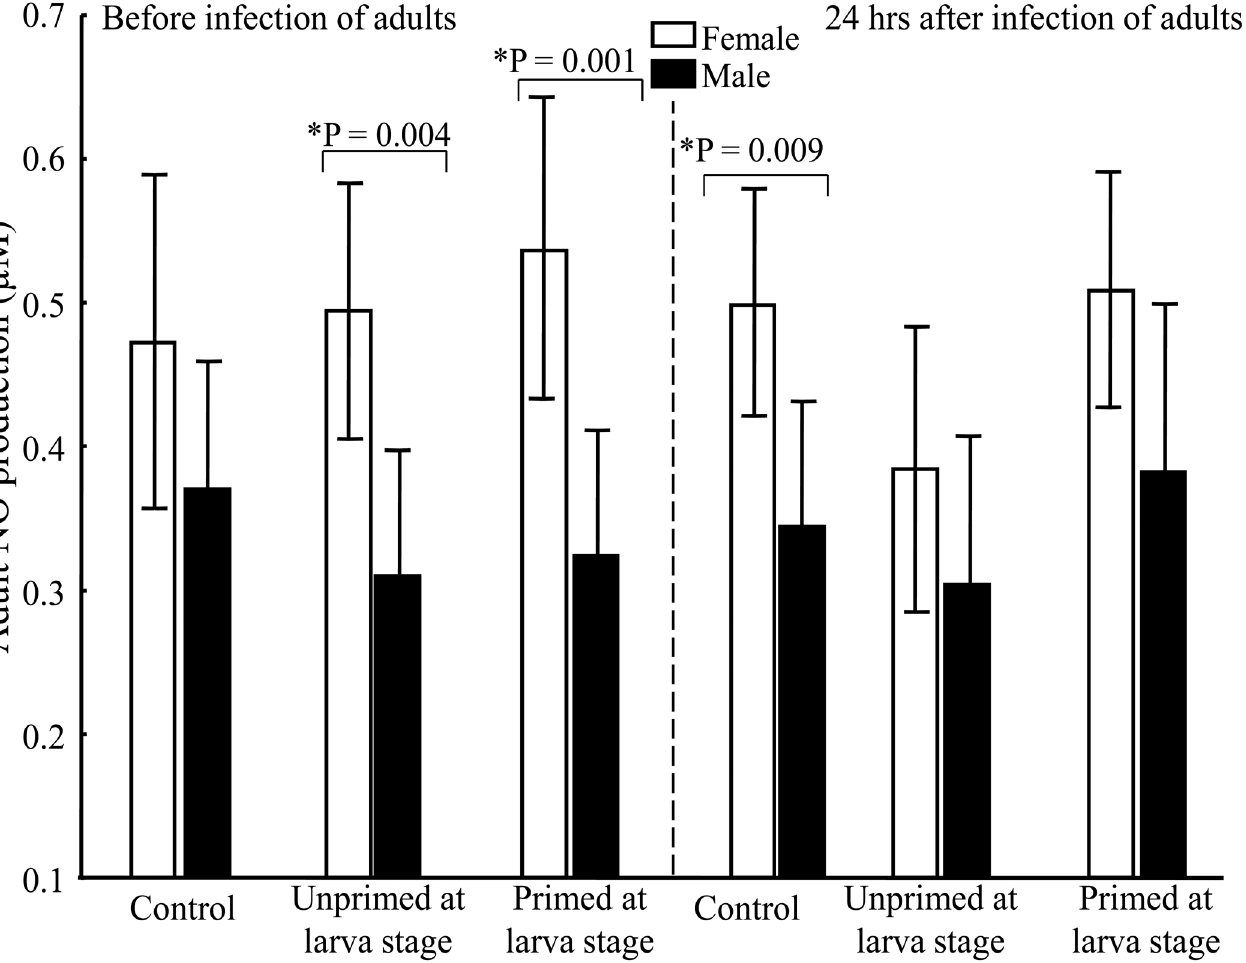
Fig 4. Gender differences in nitric oxide production (expressed as μ M). ( * ) indicates a significant difference between genders within treatment groups. Three mosquitoes were used to obtain a single sample. Number of samples per group before infection: ♀ = 14, ♂ = 24 for C; ♀ = 24, ♂ = 26 for UnPr; ♀ = 18, ♂ = 26 for Pr. Number of samples per group 24 h after infection: ♀ = 30, ♂ = 26 for C; ♀ = 28, ♂ = 14 for UnPr; ♀ = 19, ♂ = 18 for